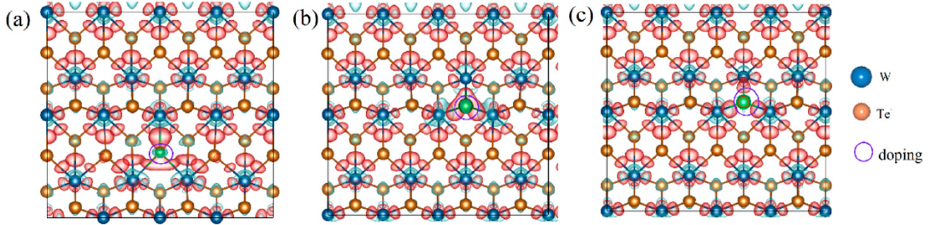
Figure 3. Differential charge density of the WTe 2 with ( a ) B-, ( b ) C-, and ( c ) P-doping, respectively. The red color indicates charge accumulation and green denotes charge depletion, while the purple circles denote doping sites.